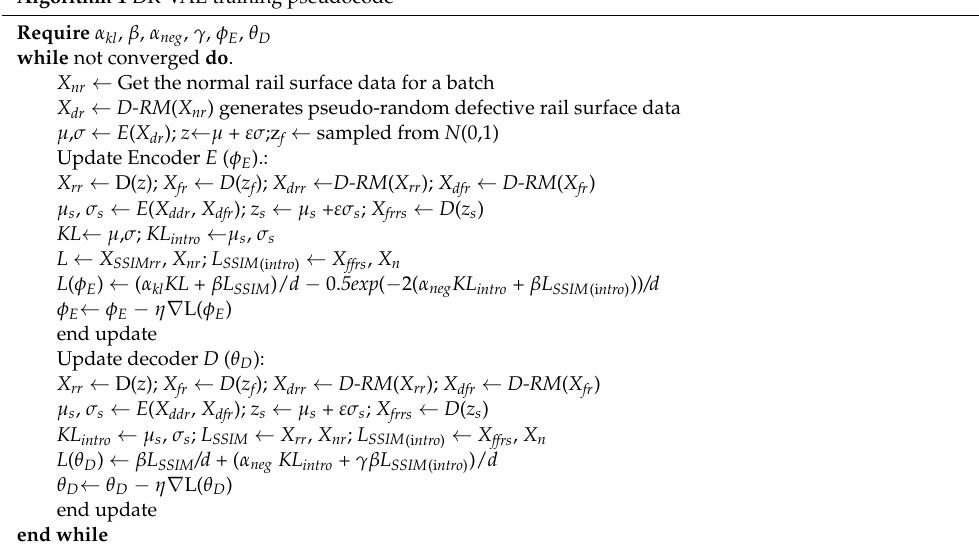
Algorithm 1 DR-VAE training